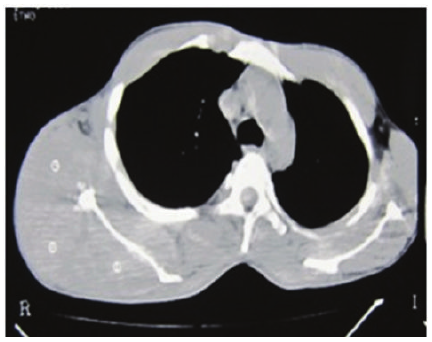
Figure 3: Contrast enhanced CT scan showing huge scapular swelling.